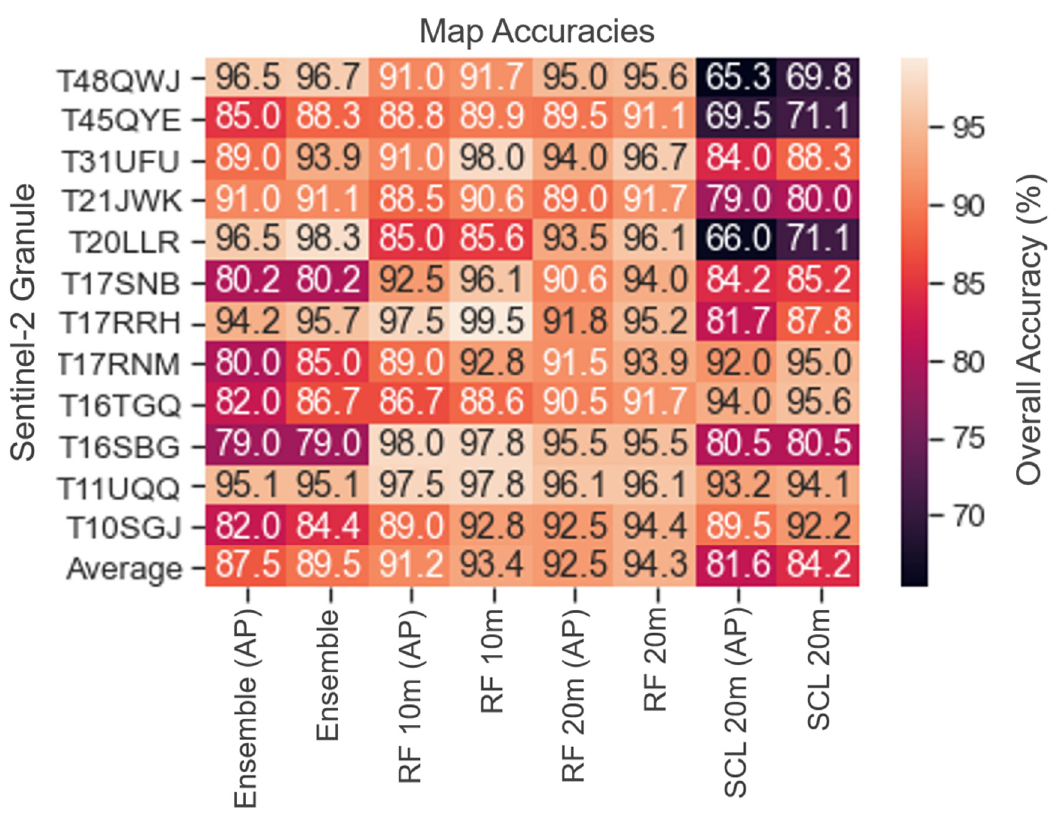
Figure 9. Overall accuracy for each Sentinel-2 granule and the average for the four different algorithms (ensemble-only, 20 m ensemble with random forest, 10 m index with random forest, and Sentinel-2 20 m SCL algorithm). The accuracies are compared for both a) 100 water and 100 not water points per site stratified in quantiles of NDWI, and b) with 20 additional points (AP) generated per granule on likely error pixels (isolated 1- or 2-pixel clusters).